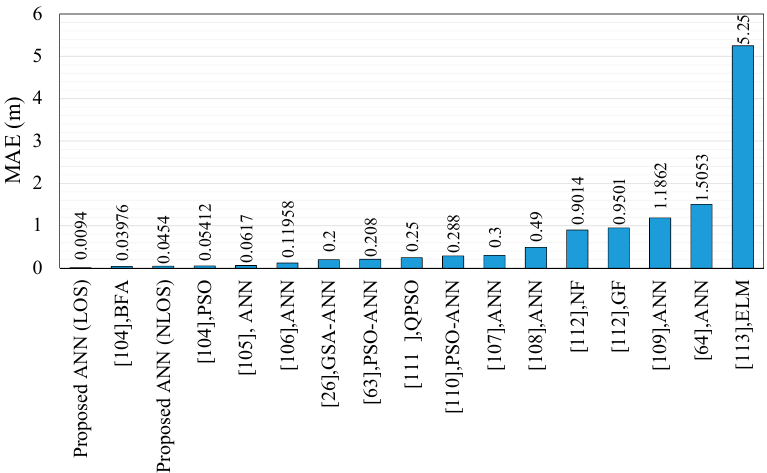
Figure 26. Comparison between MAE of the proposed ANN technique and previous techniques.